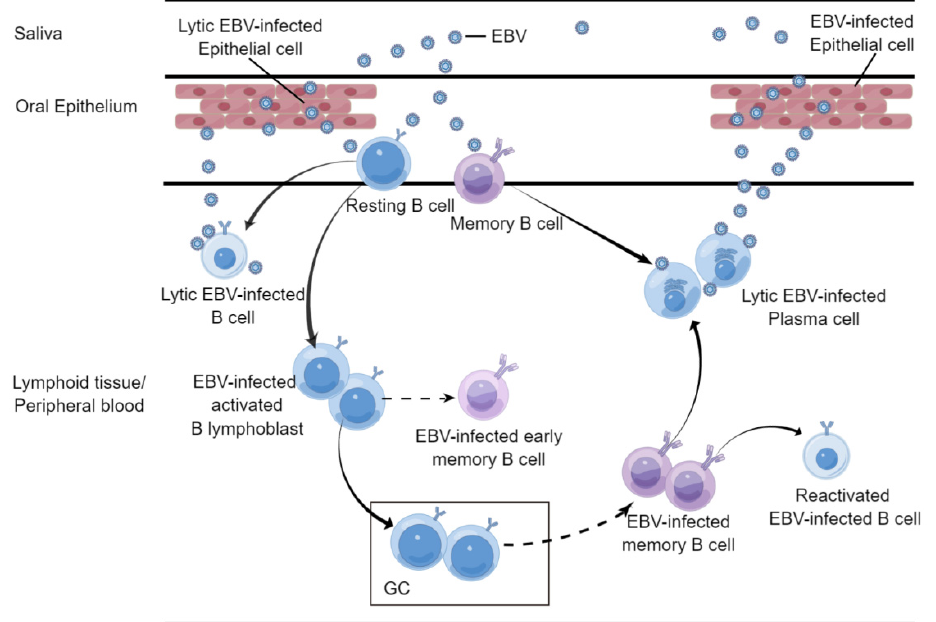
Figure 1. Model illustrating the infection of EBV in human. EBV is usually transmitted through saliva and first comes across oropharynx and tonsils of the new host, where it primarily infects naïve B cells and possibly memory B cells and epithelial cells as well. EBV establishes latent infection in most naïve B cells, while a small fraction of them might enter productive lytic infection. The latently infected naïve B cells are activated and undergo a phase of rapid expansion as a result of EBV latent gene expression. These activated infected B cells then enter the germinal center (GC), transiting to a more restricted form of viral latency. Finally, the infected B cells differentiate into resting memory B cells, where EBV nearly completely stops its gene expression and maintains its lifelong persistence, but the details of this process are still poorly understood. The EBV-infected resting memory B cells recirculate in the peripheral blood. Under certain stimulations, these resting memory B cells can differentiate into plasma cells, reenter a lytic infection state, and produce infectious virions. These virions lack in gp42 and are more epithelium-tropic. After infecting epithelial cells, the virus replicates lyses